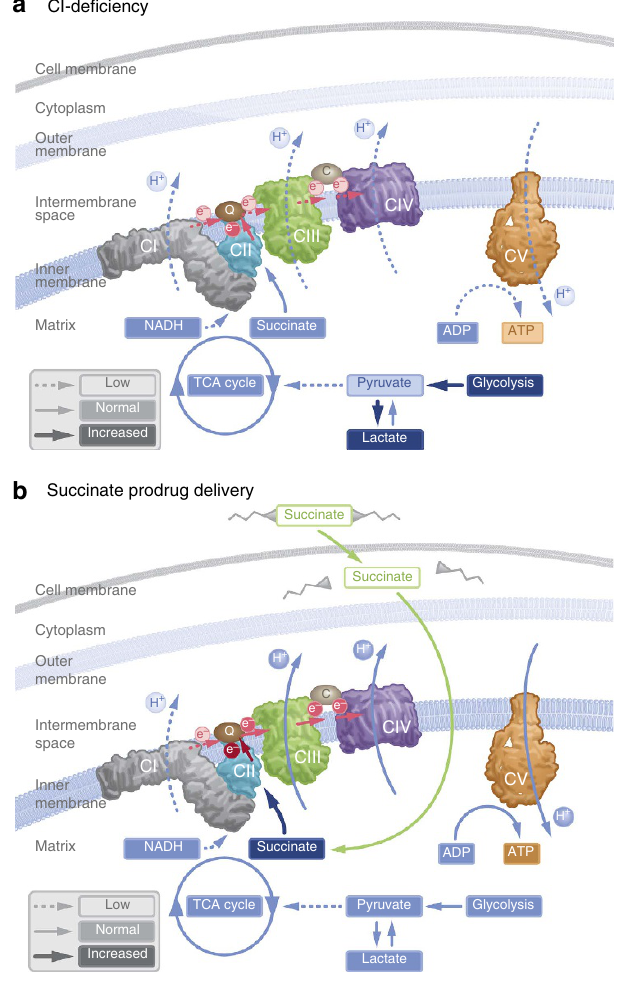
Figure 4 | Delivery of succinate to the intracellular space via a prodrug strategy. ( a ) Dysfunction in mitochondrial complex I reduces electron flow through the respiratory chain, shift metabolism towards glycolysis, induce lactate accumulation and limit ATP production. ( b ) Cell membrane- permeable prodrugs of succinate access the intracellular space and release succinate, enabling increased electron transport, respiration and ATP production through complex II, thus bypassing the deficiency in mitochondrial complex